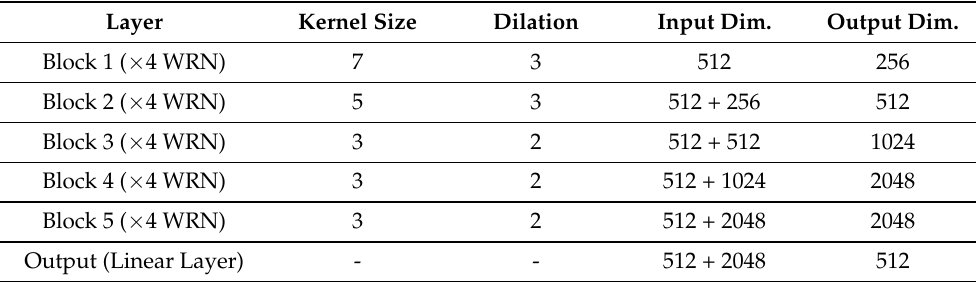
Table 1. Description of the network dimensions of the architecture used for estimating G MMSE . The dimension corresponds to the number of channels in the sequence of the processed frames. Layer Kernel Size Dilation Input Dim. Output